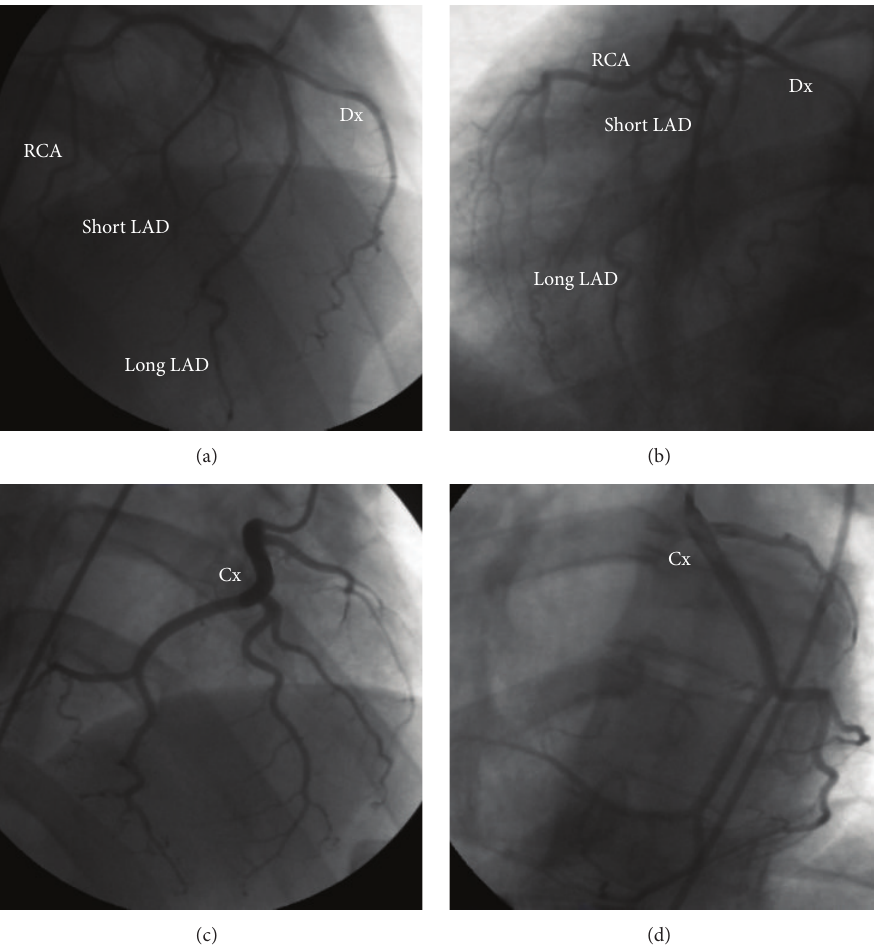
Figure 1: Coronary angiography (CRA 24 RAO 10 and CAU 24 LAO 34) showing dual LAD ((a), (b)) and (CRA 24 RAO 12 and CAU 21 LAO 32) lone Cx giving off the posterior descending artery ((c), (d)). CRA: cranial; RAO: right anterior oblique; CAU: caudal; LAO: left anterior